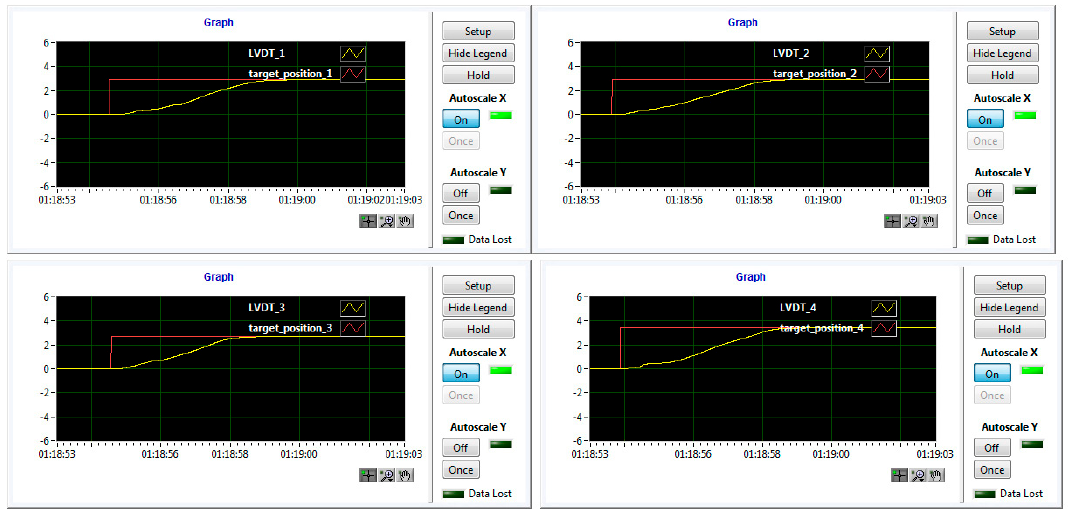
Figure 17. Actuators real-time monitoring for the M = 0.2, α = 2 ◦ , and δ = 4 ◦ flow case with the wing morphed.